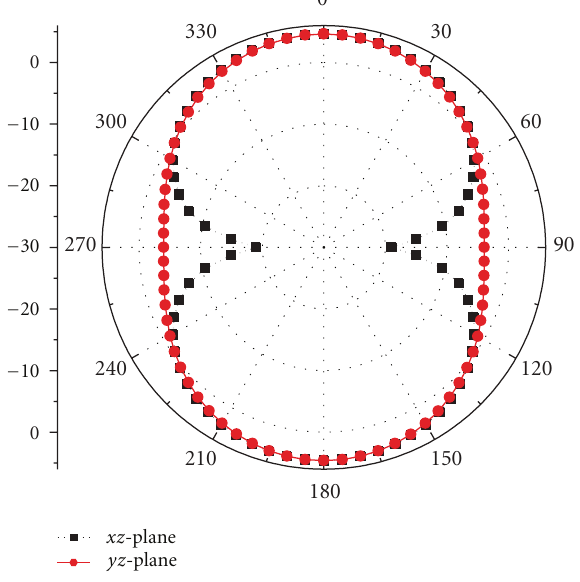
Figure 10: Simulated radiation patterns of the reference rectangular loop antenna at 2.45 GHz.